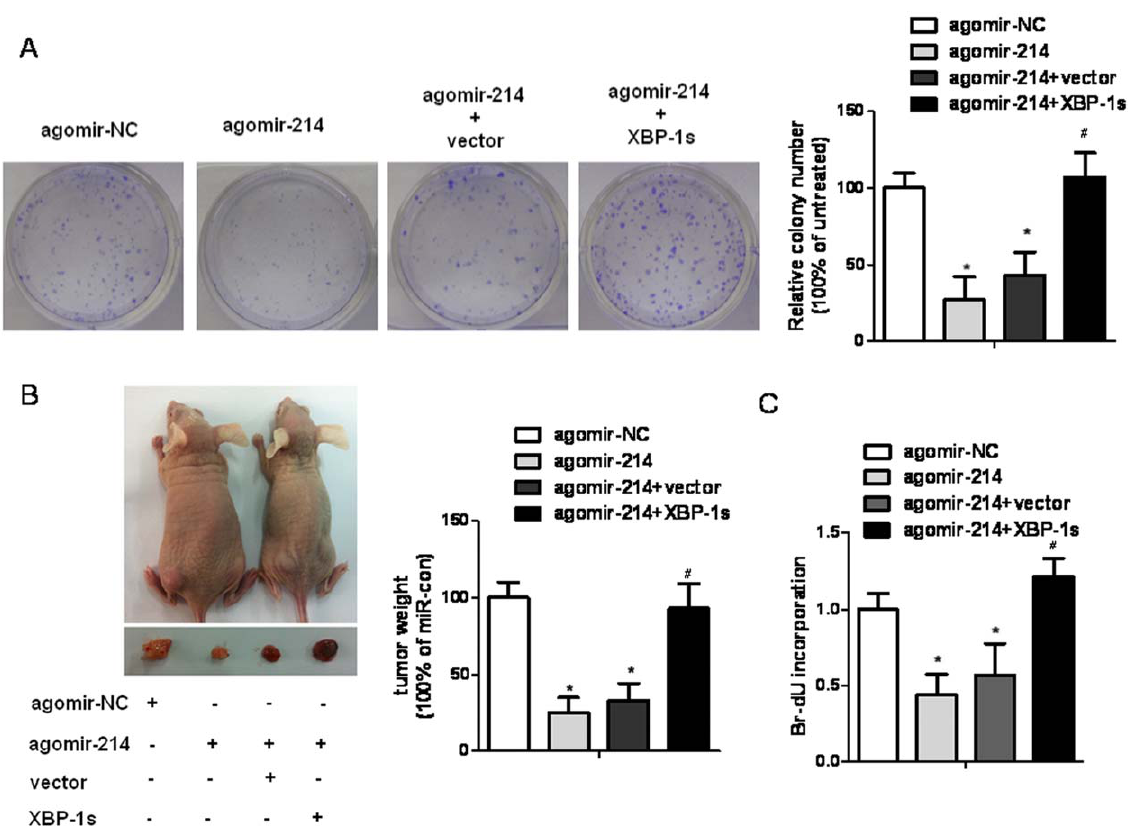
Figure 4. Restored XBP-1 expression reduced miR-214 overexpression induced HCC tumor suppression in vitro and in vivo. ( A ) XBP- 1 reintroduced reversed the suppression of colony formation induced by agomir-214 treatment in SMCC-7721 cells. ( B ) XBP-1 reintroduced reversed the suppression of tumor formation induced by agomir-214 treatment in nude mouse SMCC-7721 cells xenograft model. Tumor weight 4 weeks after inoculation was measured. ( C ) XBP-1 reintroduced reversed the suppression of cells proliferation induced by agomir-214 treatment in SMCC-7721 cells. The results were reproducible in three independent experiments. *P , 0.05 vs agomir-NC-treated; # P , 0.05 vs agomir-214 or agomir- 214 +